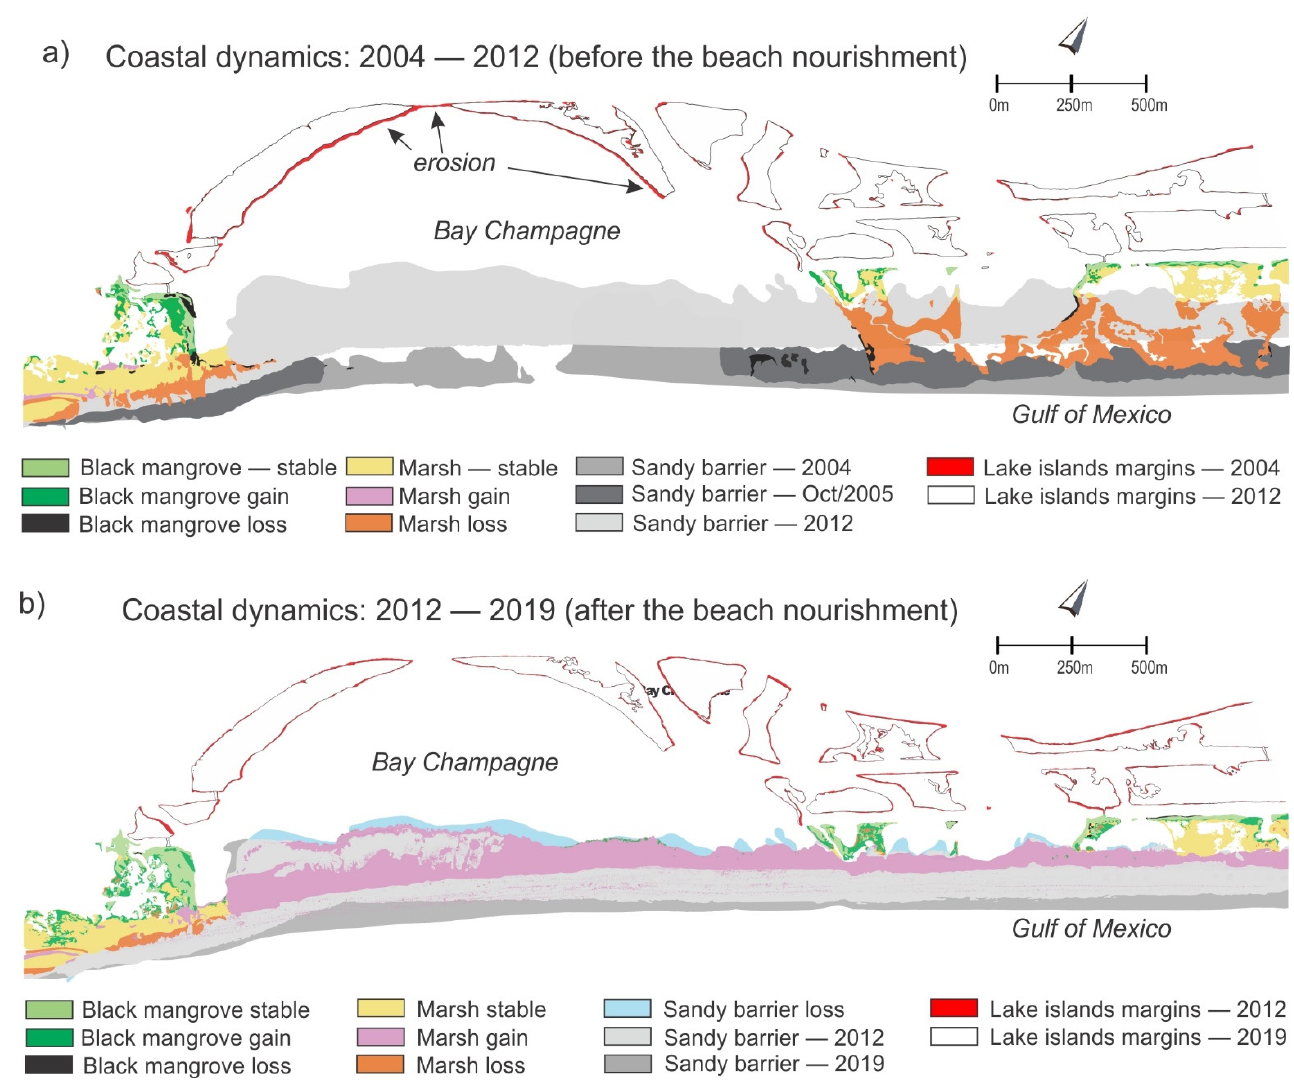
Figure 8. Spatial-temporal analysis of backbarrier wetlands in the Bay Champagne, based on satellite and drone images ( a ) before (2004—2012) and ( b ) after (2012—2019) the beach nourishment project.